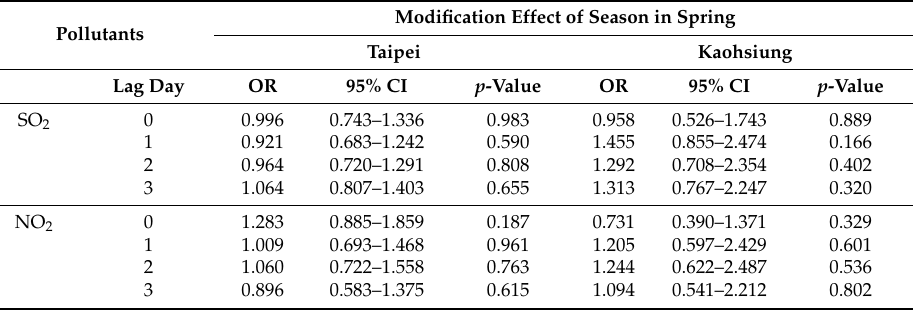
Table 4. Association between air pollution and childhood asthma in spring.